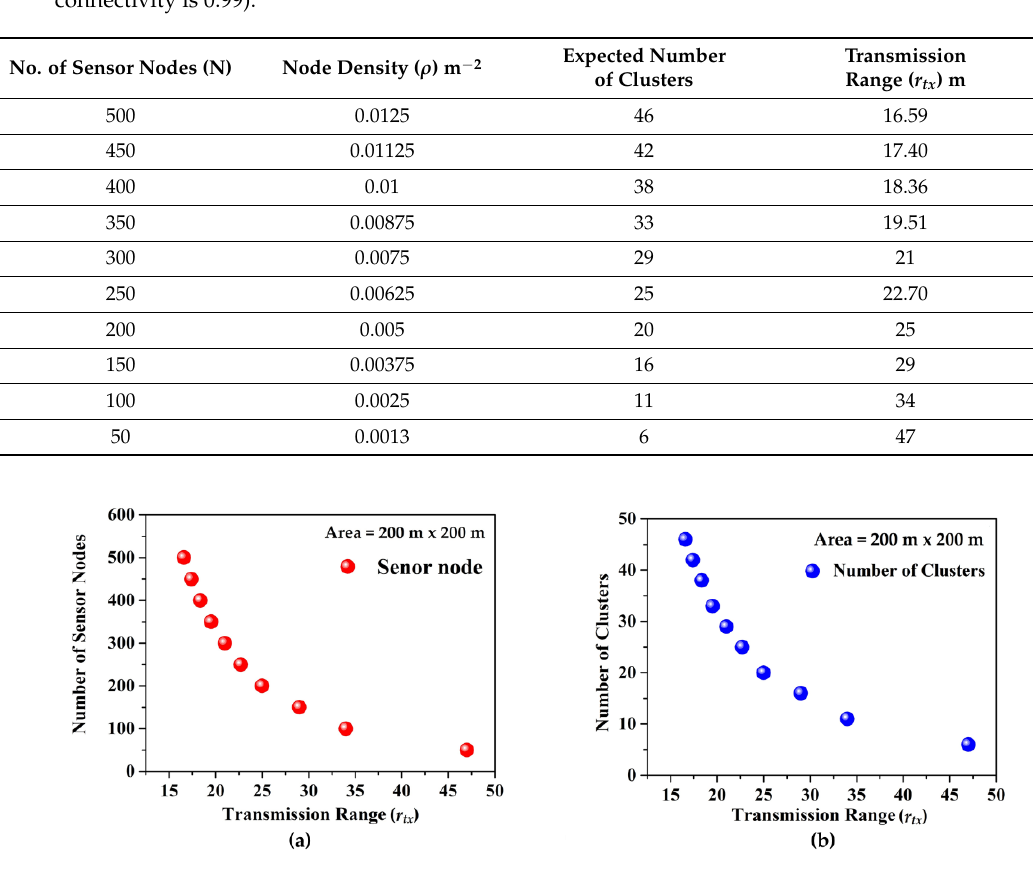
Table 6. Computation parameters and values.